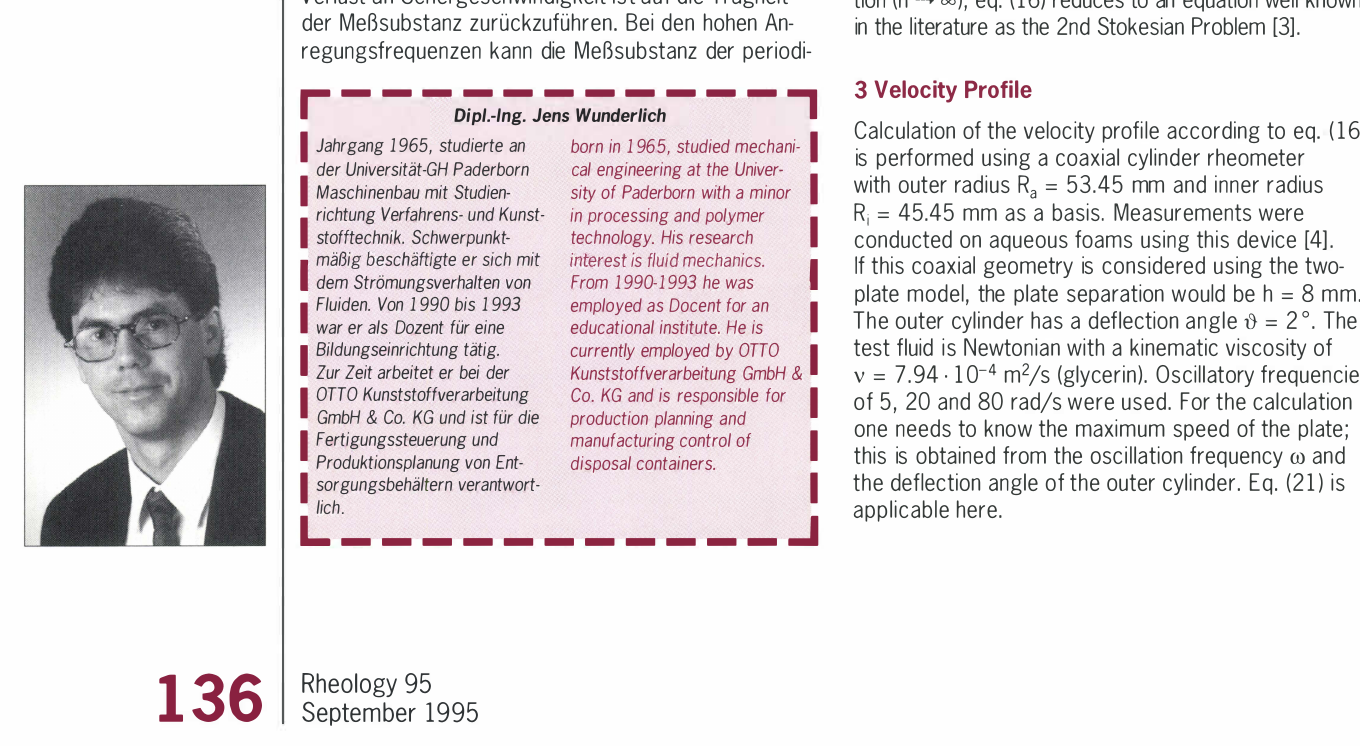
in the literature as the 2nd Stokesian Problem [3].